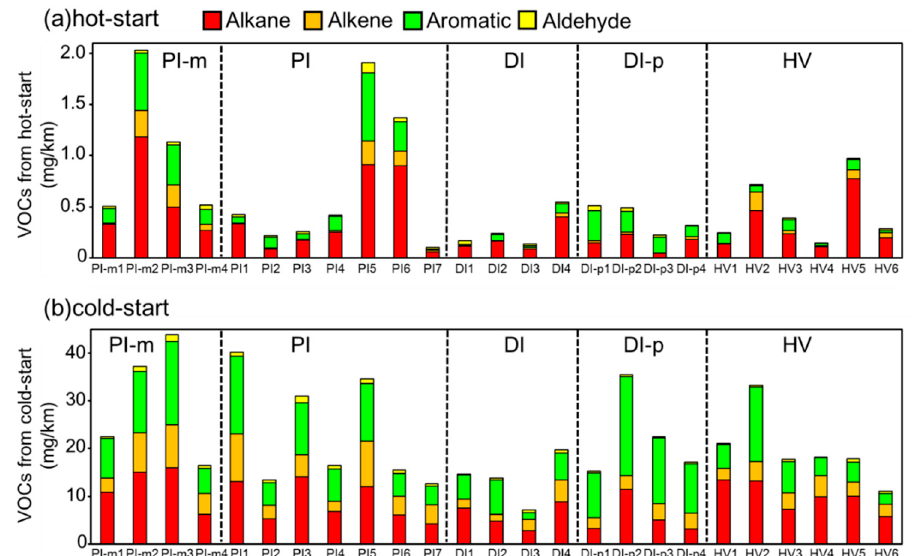
Figure 1. Total volatile organic compound (VOC) emissions for the 25 vehicles measured in this study following a ( a ) hot-start and ( b ) cold-start. (PI-m: mini-sized port injection, PI: standard-sized